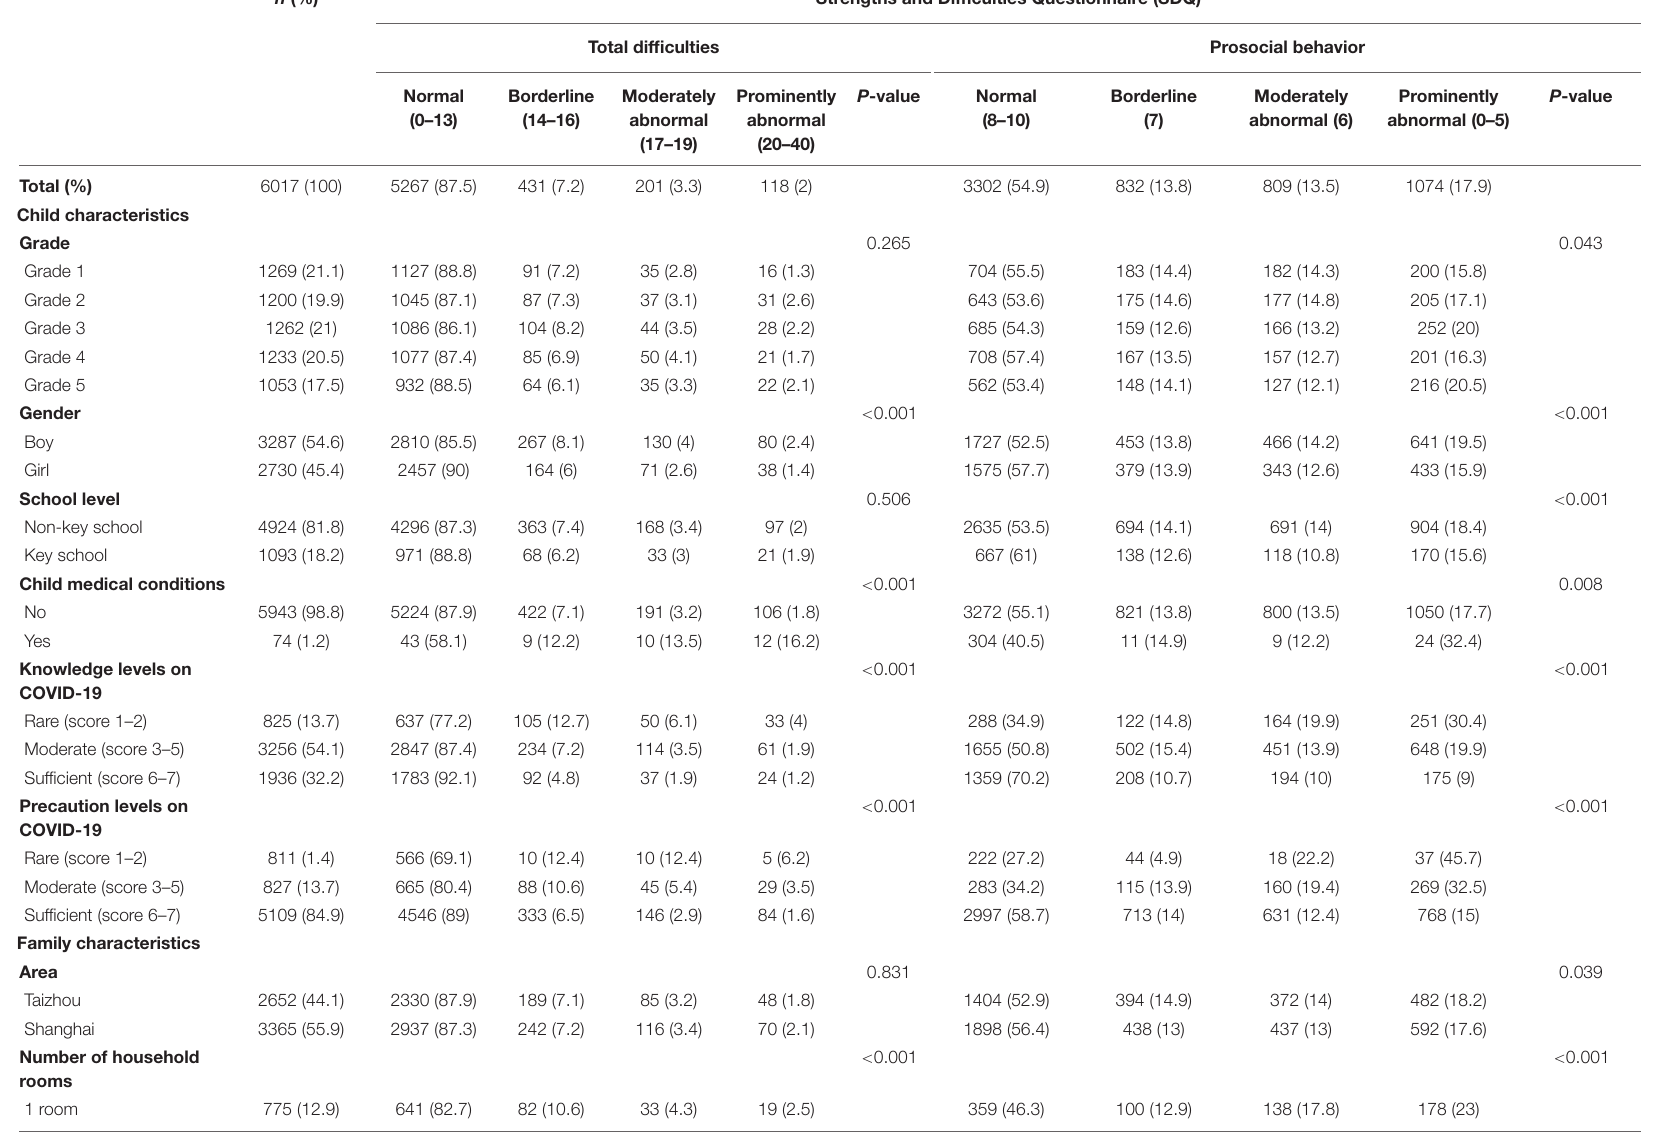
TABLE 1 | Distributions of total difficulties scores and prosocial behavior scores by different